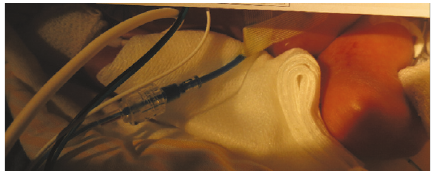
Figure 2: Infant in supine position, ascitic drain in the right abdomen filled with blue